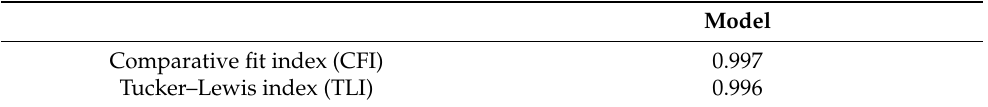
Table 3. User model versus baseline model.